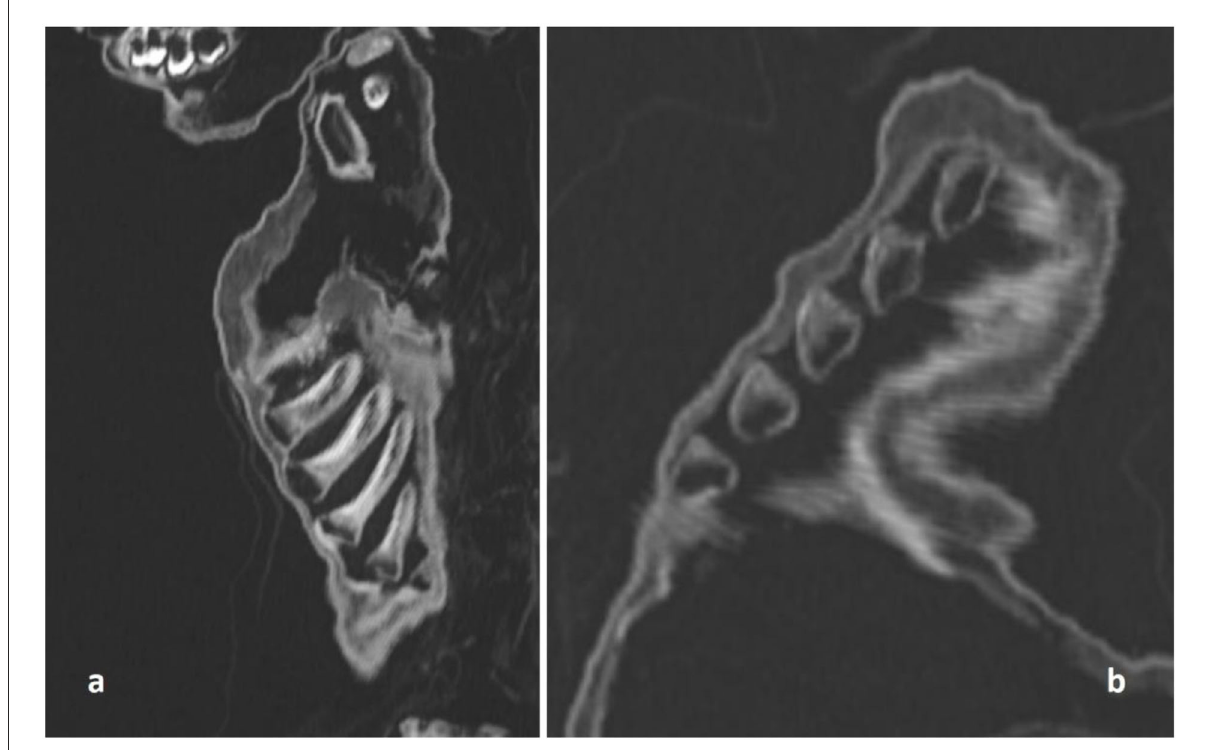
FIGURE5 CT scan of the costochondral junction with an enlargement such as seen in “rickety rosary” but also in “scurvy rosary.” (a) Sagittal section; (b) oblique